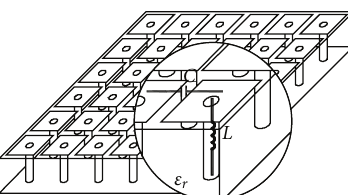
Figure 1: High impedance surface and its model with parallel resonant LC circuit. The substrate is transparent in order to get better visualization of metallic vias.